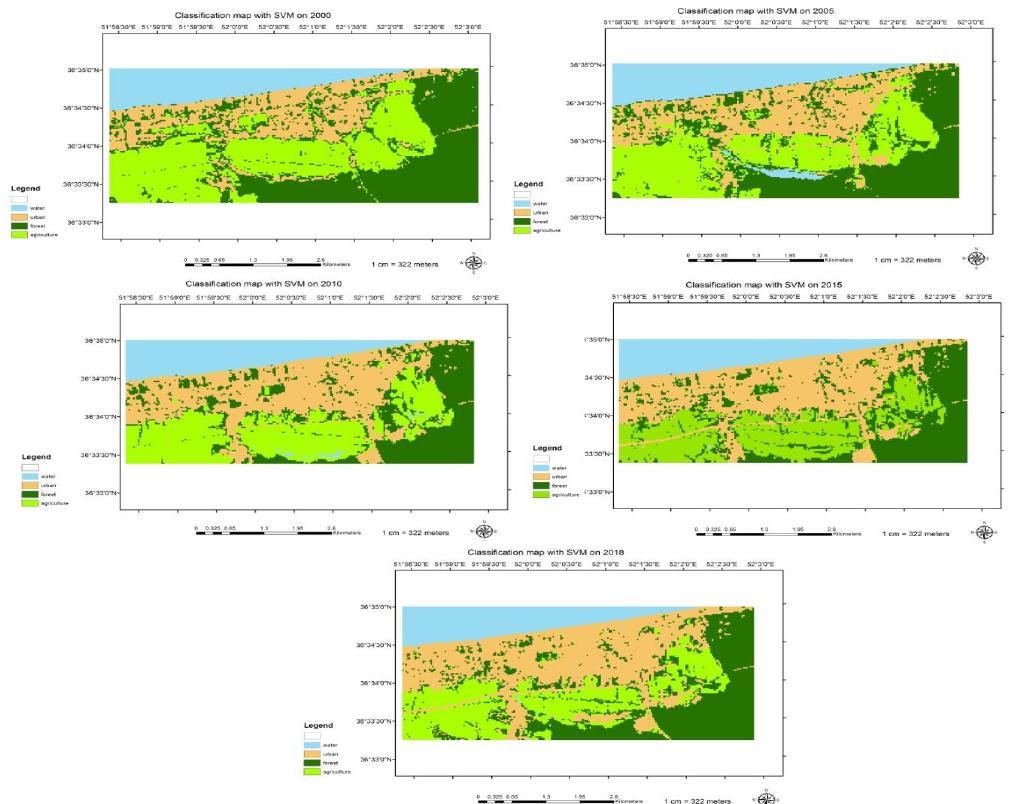
Figure 2. SVM classification map from 2000 to 2018, respectively; there are four classes; water (blue colour), urban (cream colour), agriculture (light green colour), urban forest (dark green colour). After classification, land use maps are compared in order to obtain changed areas between 2000 and 2018.